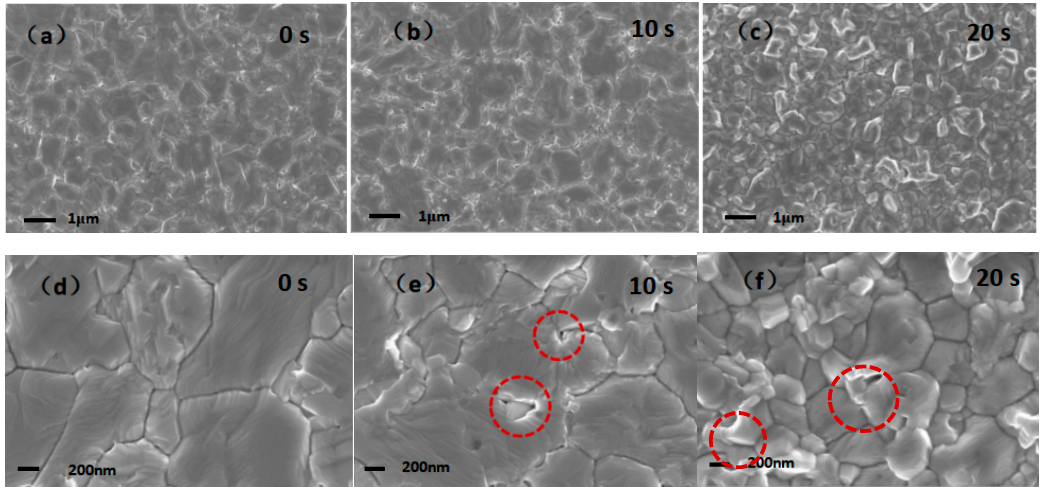
Figure 1. Top views of organic–inorganic hybrid perovskite films with different PbI 2 annealing